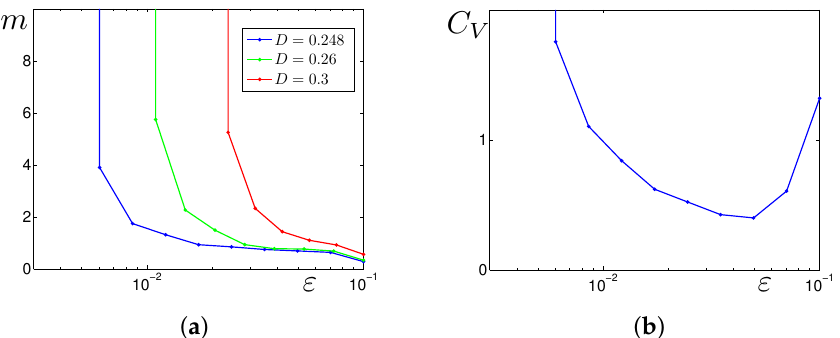
Figure 9. Frequency characteristics of oscillations in the stochastic system: ( a ) mean values m of interspike intervals, ( b ) coefficient of variation for D =